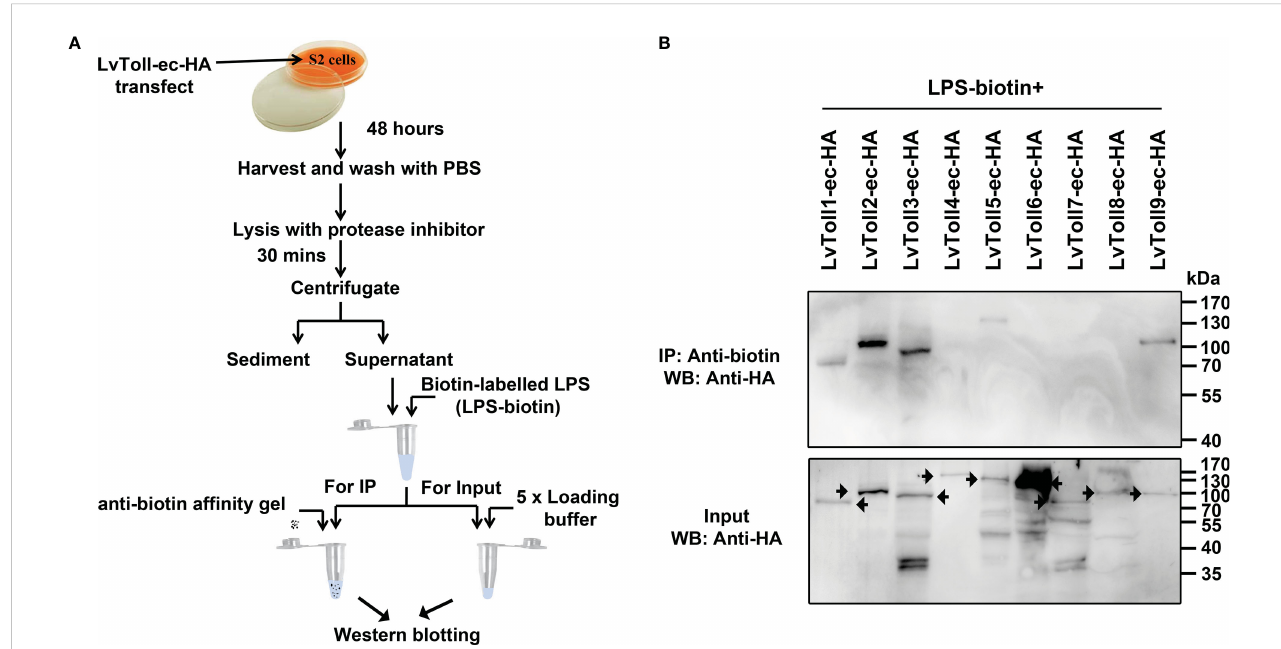
FIGURE 1 Screening a total of nine LvTolls that recognize LPS. (A) The fl ow chart of the in vitro LPS-LvTolls interaction experiments. The extracellular domain of LvTolls was individually over-expressed in S2 cells. Forty-eight hours after transfection, cells were harvested and lysed. The supernatant of cell lysis was incubated with biotin labeled LPS, which was further incubated with the anti-biotin agarose. (B) The interaction between LPS and LvToll-ec. The extracellular domain of Toll easily presents heterozonal bands. The black arrow stands for the band that corresponds to the